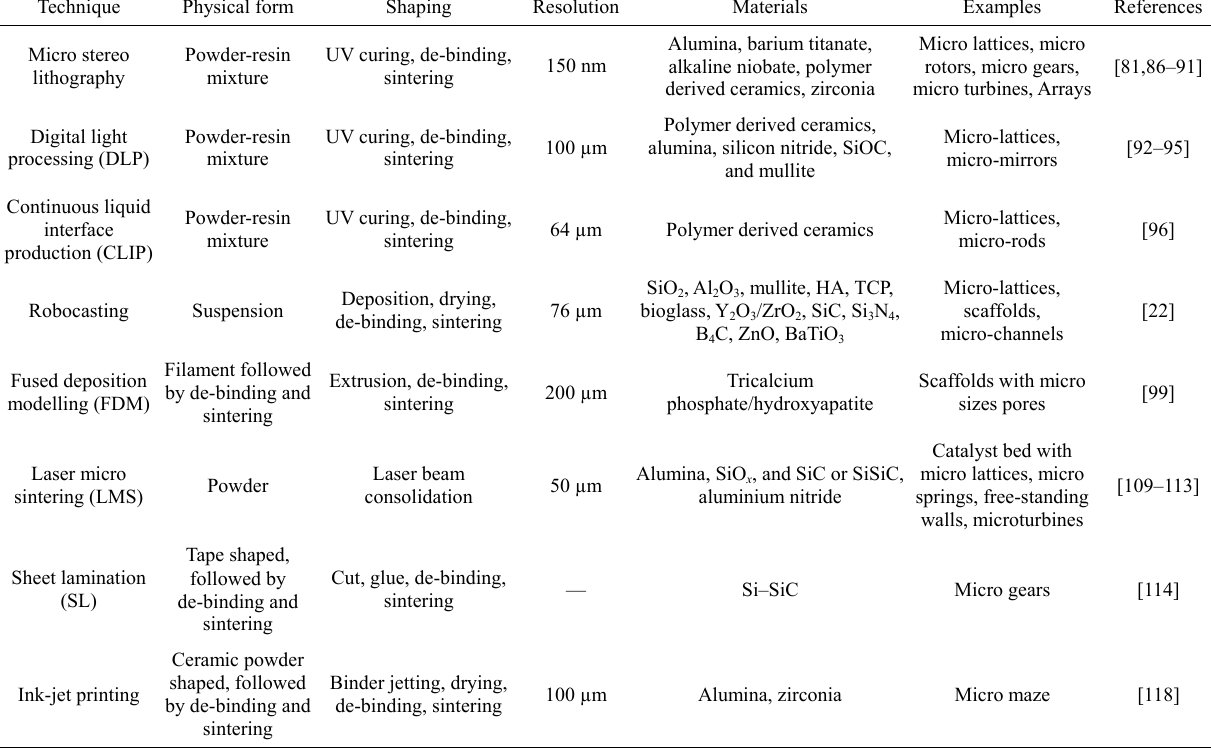
Fig. 16 SEM image of the sintered maze built by ink-jet printing. Reproduced with permission from Ref. [118], © The American Ceramic Society 2002. Table 2 Summary of AM techniques used for MEMS